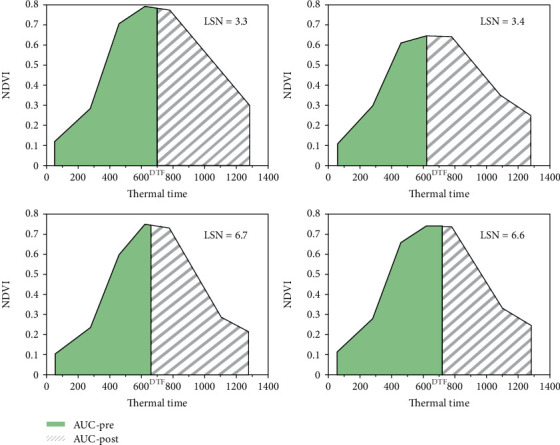
Example plots of sorghum hybrids in Jimbour. AUC-pre: area under the curve preanthesis; AUC-post: area under the curve postanthesis; DTF: days to flowering which were used as a separator between the left and right areas under the curve. The upper plots show low leaf senescence (LSN) values and the lower plots show high LSN values.